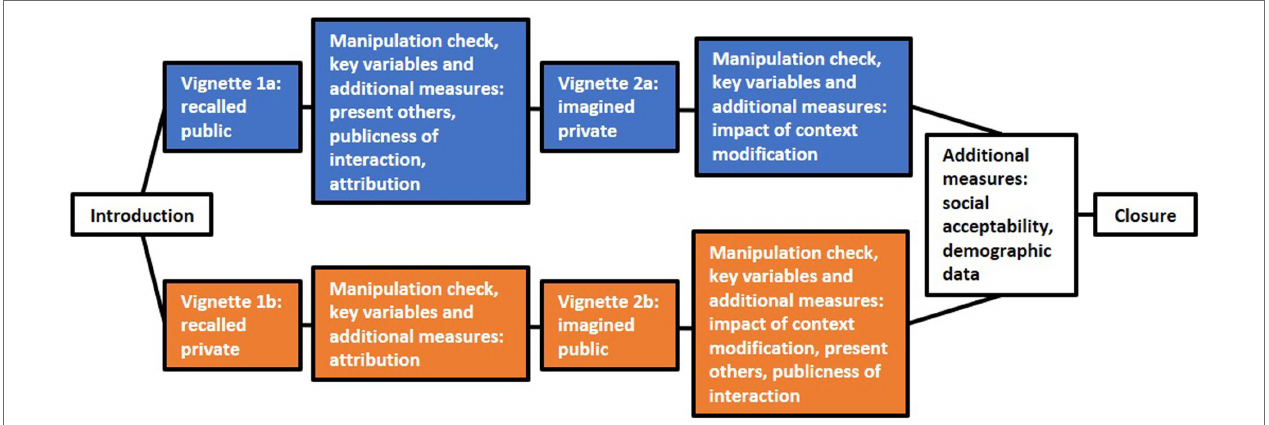
FIGURE 1 | Procedure of the study. The same selection of items was presented to participants of both experimental conditions (in a different sequence). Key variables = need fulfillment and